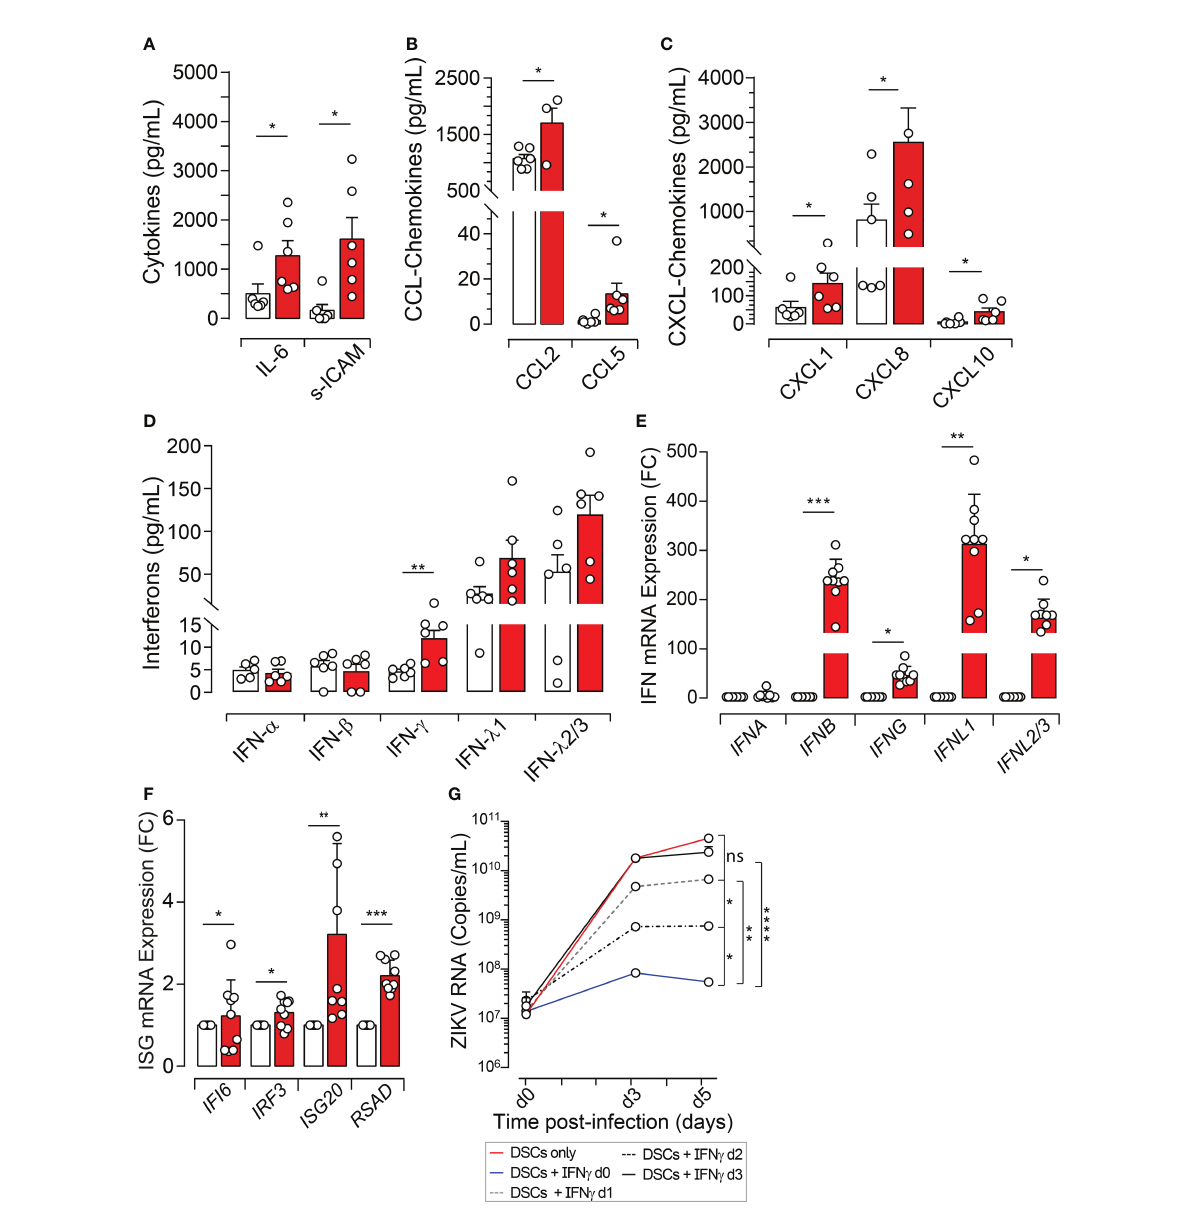
FIGURE 3 ZIKV Infection Modulates the Decidual Environment and the Interferon Response. DSCs were infected with ZIKV at an MOI of 1. (A) Cytokines, (B) CCL-chemokines, (C) CXCL-chemokines, (D) IFN- a , IFN- b , IFN- g , IFN- l 1 and IFN- l 2/3, quanti fi ed in the supernatant using a 42-multi- plexed cytokine assay 48 hours post-infection. (E, F) Total mRNA extracted 3 dpi and transcripts quanti fi ed using qRT-PCR and speci fi c primers for IFNA , IFNB , IFNG , IFN L1, IFNL2/3 , IFI6 , IRF3 , ISG20 and RSAD . Histograms showing signi fi cant differences between uninfected (white bars) and ZIKV-infected DSCs (red bars) are presented as fold change of relative mRNA expression (FC). (G) ZIKV-infected DSCs cultured with or without recombinant human IFN- g (100ng/mL). IFN- g was added at day 0 (d0, blue line), d1 (dotted black line), d2 (dotted grey line) or d3 (black line) post-infection. Non treated ZIKV-infected DSCs (red line) are used as positive control. Culture supernatants were collected from the different conditions following the indicated time points and viral loads were determined by qRT-PCR. All data sets are normalized and presented as mean values ± SEM from at least fi ve independent donors. Statistical signi fi cance of differences was evaluated by repeated-measures analysis of variance with the Greenhouse and Geisser correction, and the Newman-Keuls post hoc test. ns, not signi fi cant. * p <0.05, ** p <0.01, *** p <0.001, **** p